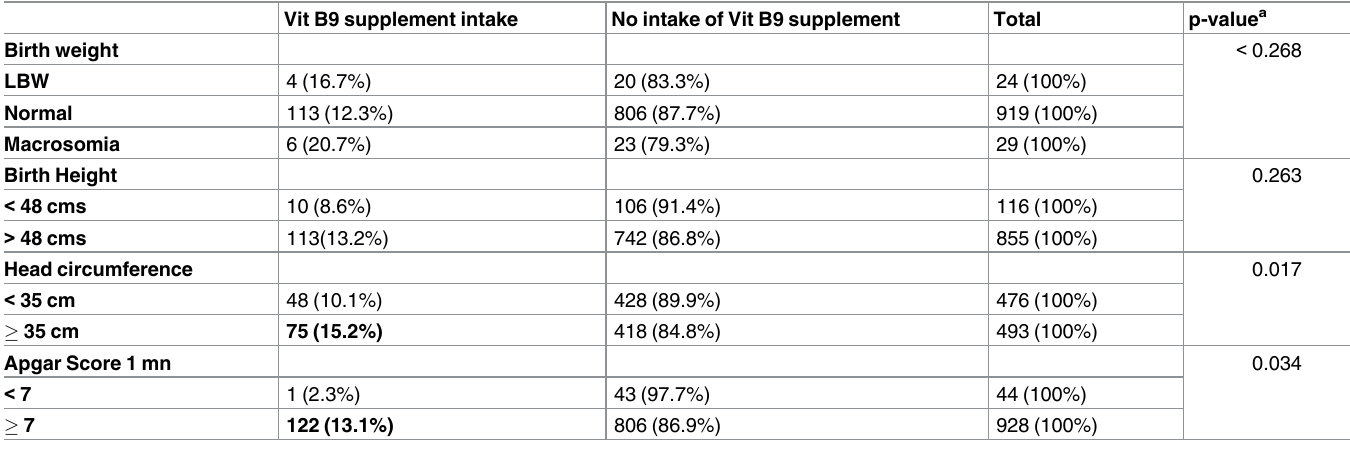
Table 10. Folic acid supplementation and neonatal